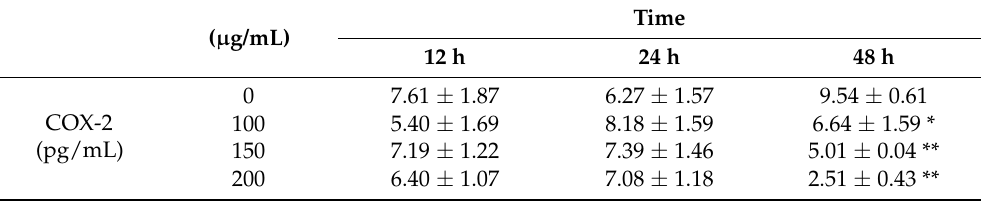
Table 11. Effect of different concentrations of GSP on COX-2 mRNA expression in mature adipocytes.